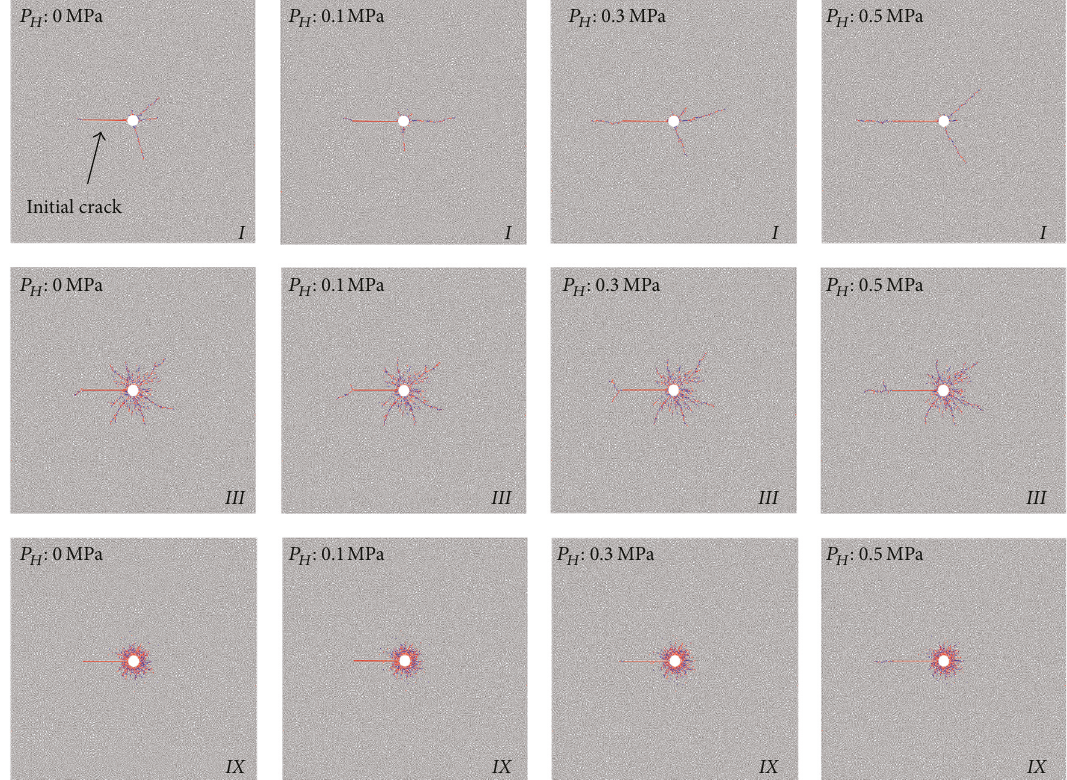
Figure 16: Crack propagation under single-impact with 𝑃 𝐻 in initial crack for groups I, III, and